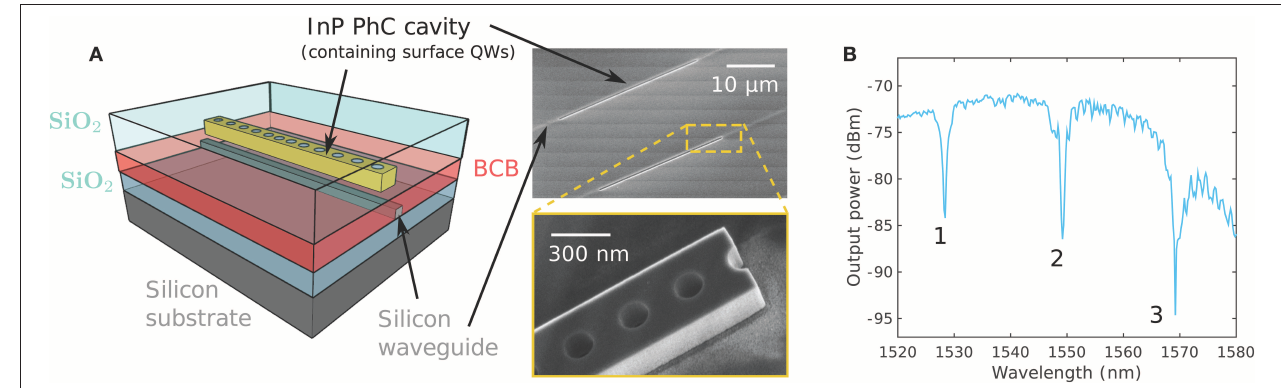
FIGURE 3 | (A) Illustration and SEM photographies of our AOGs, consisting of InP PhC “nanobeam” bonded on a SOI circuitry. BCB, benzo-cyclo-buthene; intermediate polymer used for the adhesive bonding of the III–V on the SOI sample. (B) Output power from of a nanobeam InP cavity hybridized on 350 nm wide SOI waveguide, with a flat white source centered around 1,550 nm as light input. We can observe the parabolic transfer function of the grating couplers, as well as three resonances at 1,528, 1,549, and 1,569